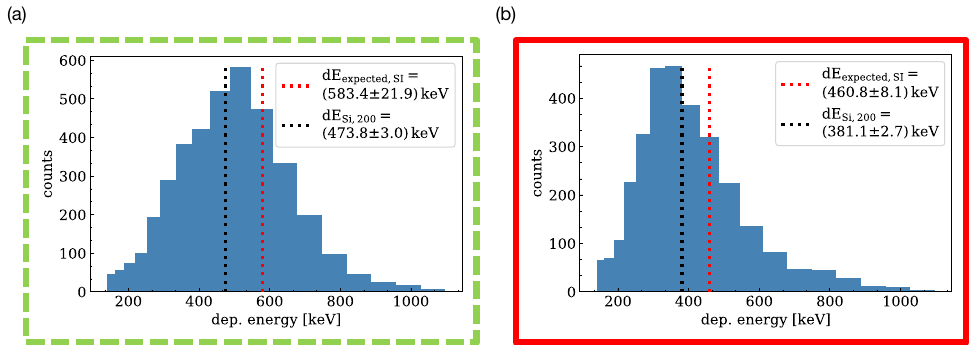
Figure 7. Deposited energy spectra for ( a ) phantom thickness of 2.0cm, corresponding to E sensor ≈ 36.8MeV and for ( b ) phantom thickness of 1.2cm, corresponding to E sensor ≈ 49.8MeV. The frames identify the ROIs according to Figure